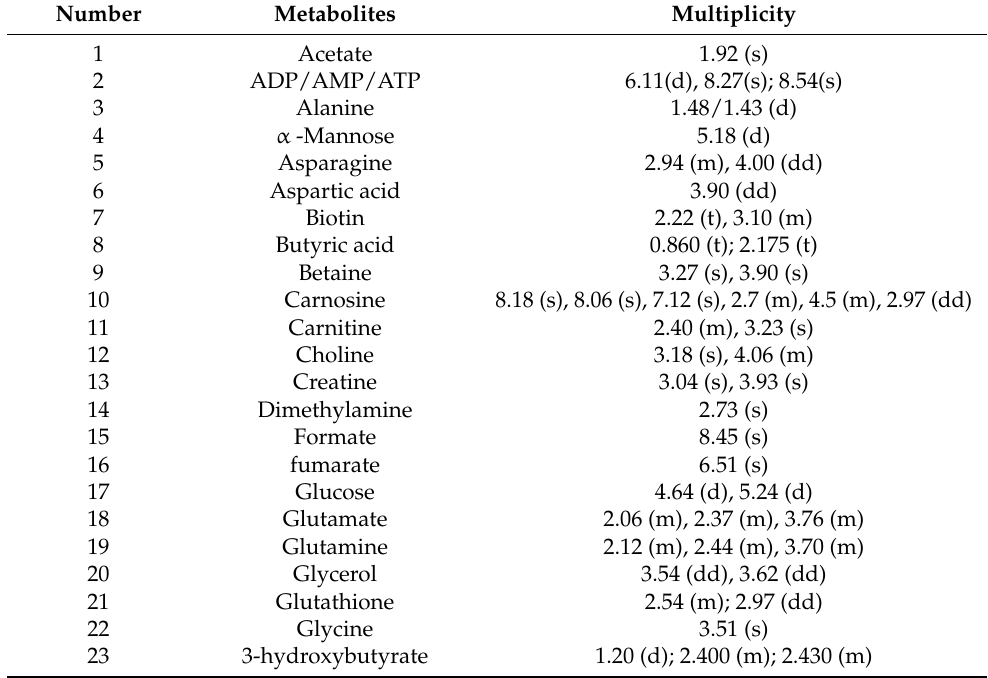
Table 1. The identified metabolites included amino acids (alanine, asparagine, aspartic acid, glutamine, isoleucine, leucine, and valine), dipeptide (carnosine), organic acids (3- hydroxybutyrate, acetate, creatine, formic acid), vitamins (biotin, glutathione), sugars (glucose, glycerol and α -mannose), nucleosides (inosine, hypoxanthine, uracil), and energy related metabolites e.g., lactate, carnitine, or ADP/AMP/ATP. Overall, stacked 1 H-NMR spectra were dominated by signals of creatine and lactate. Table 1. Metabolites identified in different meat